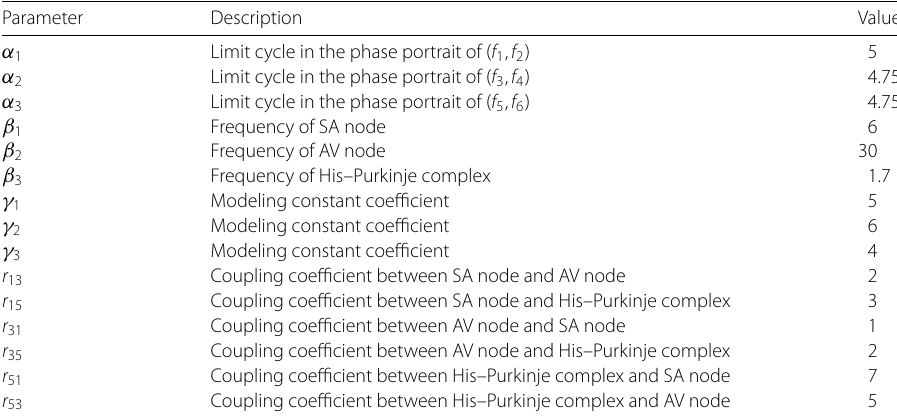
Table 1 The parameter values of model (2) Parameter Description Value α 1 Limit cycle in the phase portrait of ( f 1 , f 2 ) 5 α 2 Limit cycle in the phase portrait of ( f 3 , f 4 ) 4.75 α 3 Limit cycle in the phase portrait of ( f 5 , f 6 ) 4.75 β 1 Frequency of SA node 6 β 2 Frequency of AV node 30 β 3 Frequency of His–Purkinje complex 1.7 γ 1 Modeling constant coefficient 5 γ 2 Modeling constant coefficient 6 γ 3 Modeling constant coefficient 4 r 13 Coupling coefficient between SA node and AV node 2 r 15 Coupling coefficient between SA node and His–Purkinje complex 3 r 31 Coupling coefficient between AV node and SA node 1 r 35 2 r 51 7 r 53